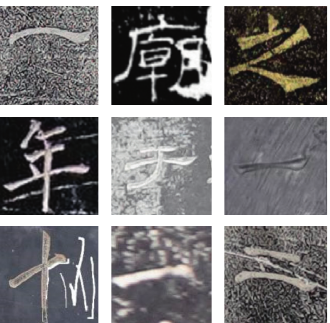
Figure 1: Different types of noise in ancient stone inscription